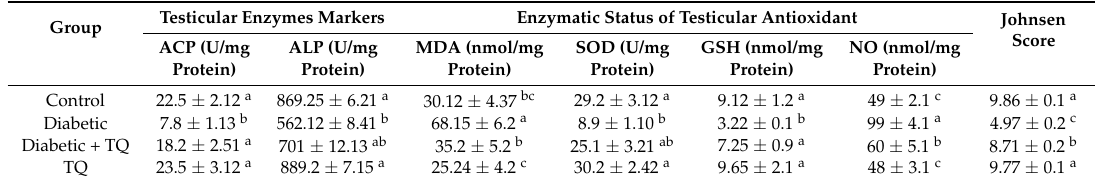
Table 2. Effect of thymoquinone (TQ) on enzyme markers of the testicles, antioxidant status, and Johnsen score in experimental groups at the 12th week. Values are given as ± SEM, and Duncan’s range test ‡ was applied.